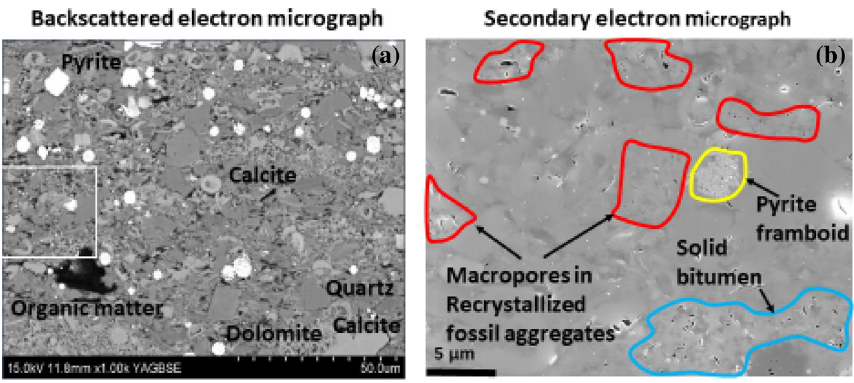
cement all indicate diagenetic transformation of the original mate- rial. b Secondary electron micrograph: Pores in recrystallized fossil aggregates occur at the interface with organic matter filling the intra-granular space